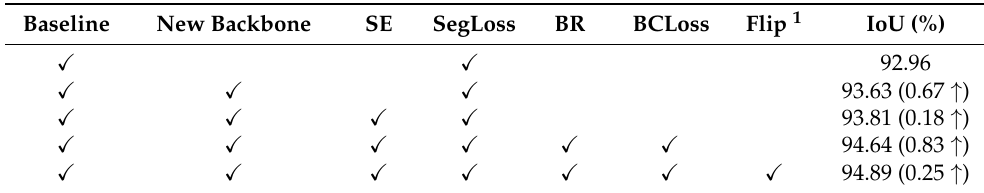
Table 6. Ablation experiments for the network design, where HRNetV2 serves as baseline. (cid:88) means the corresponding component is adopted.